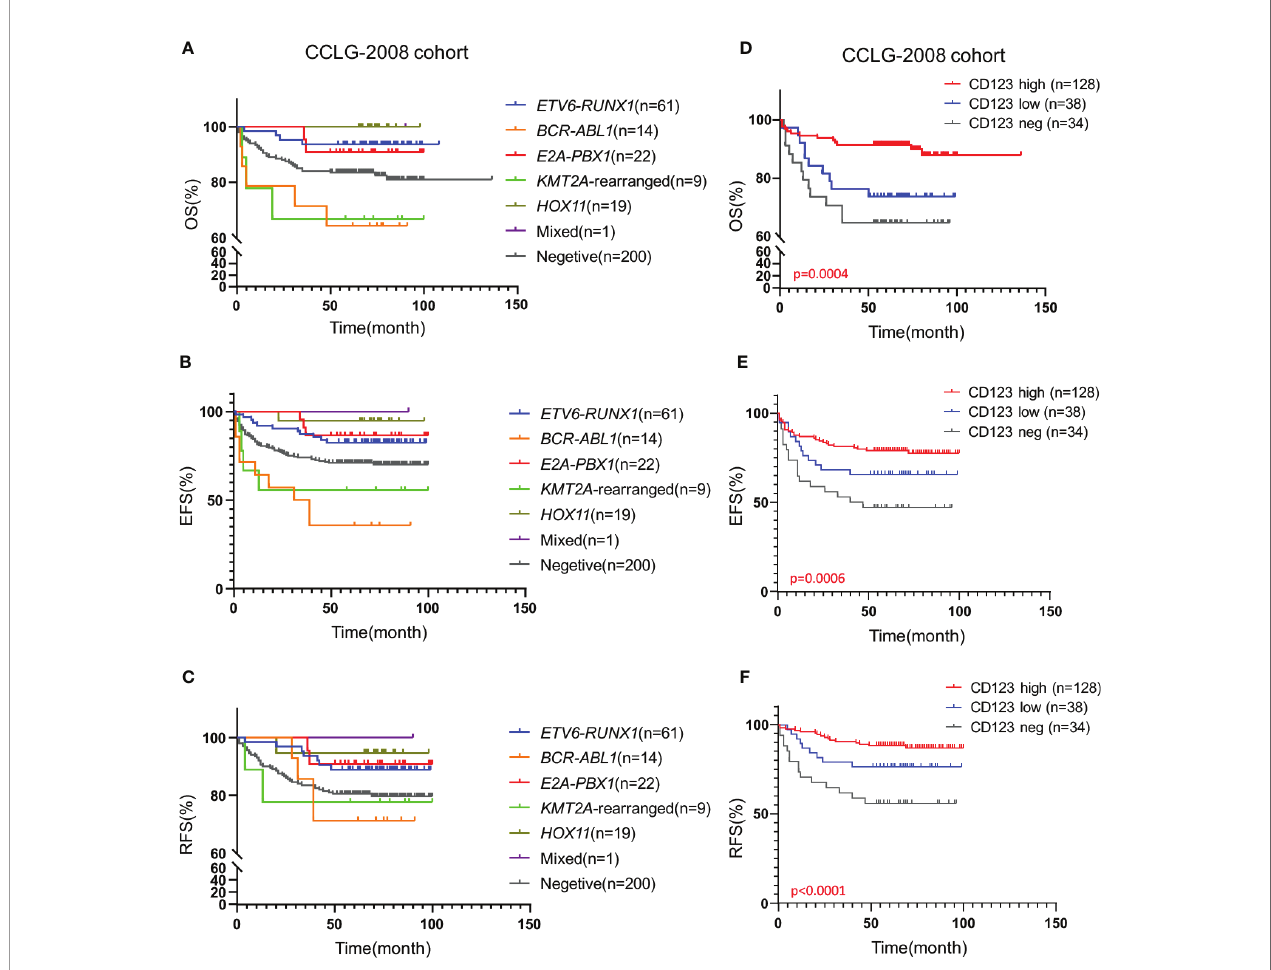
FIGURE 3 | High CD123 expression conferred favorable clinical outcomes in pediatric B-ALL lacking prognosis-de fi ning genomic abnormalities in the CCLG-ALL- 2008 cohort. Kaplan-Meier analysis of OS (A) , EFS (B) , and RFS (C) across patients with different genomic abnormalities in the CCLG-ALL-2008 cohort; Comparison of OS (D) , EFS (E) , and RFS (F) according to the CD123 expression among patients without prognosis-de fi ning genetic aberrations in the CCLG-ALL- 2008